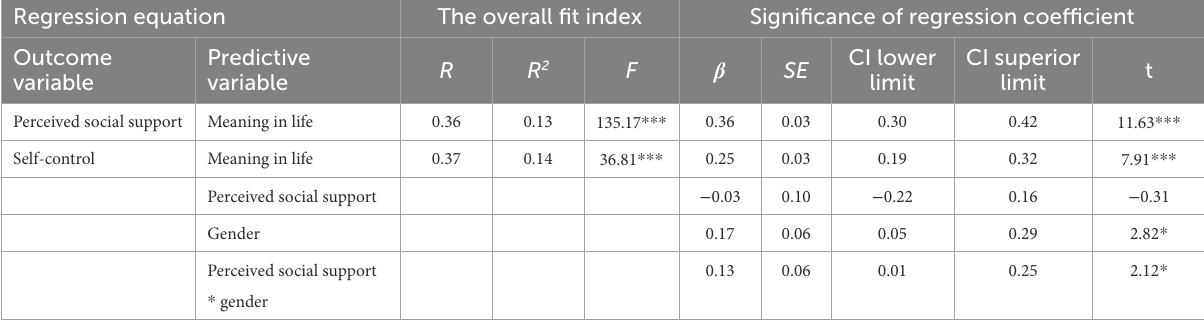
TABLE 4 Regression analysis of the moderating effect of